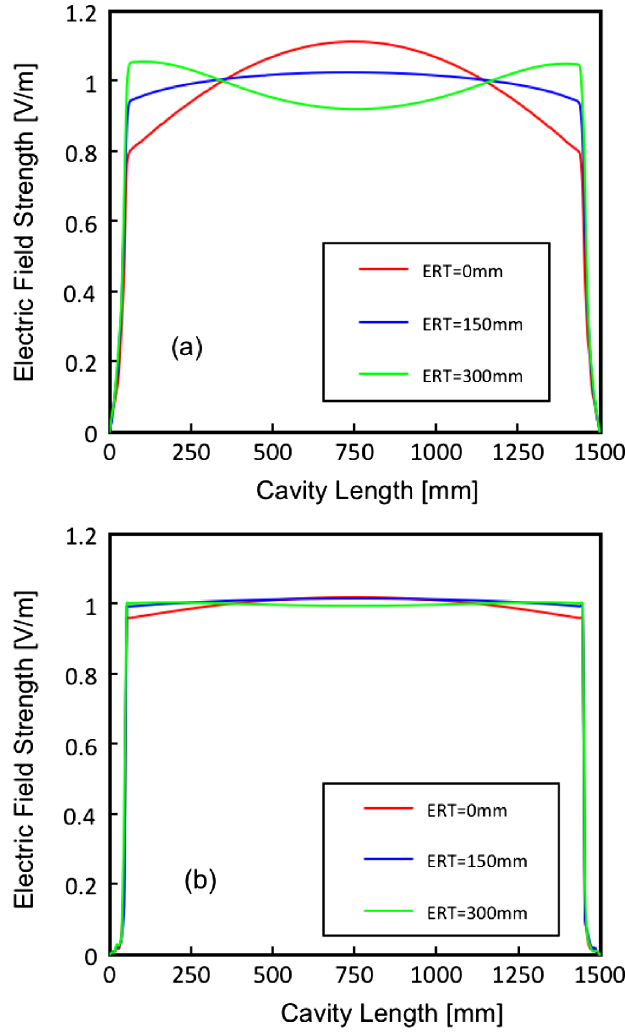
FIG. 5. Transverse electric field strength between ridges along the longitudinal direction of the cavity. Plots of electric field strength as a function of cavity length for (a) (cid:1) ¼ 20 mm (gap length between the ridges) and (b) (cid:1) ¼ 2 mm (gap length between the ridges).